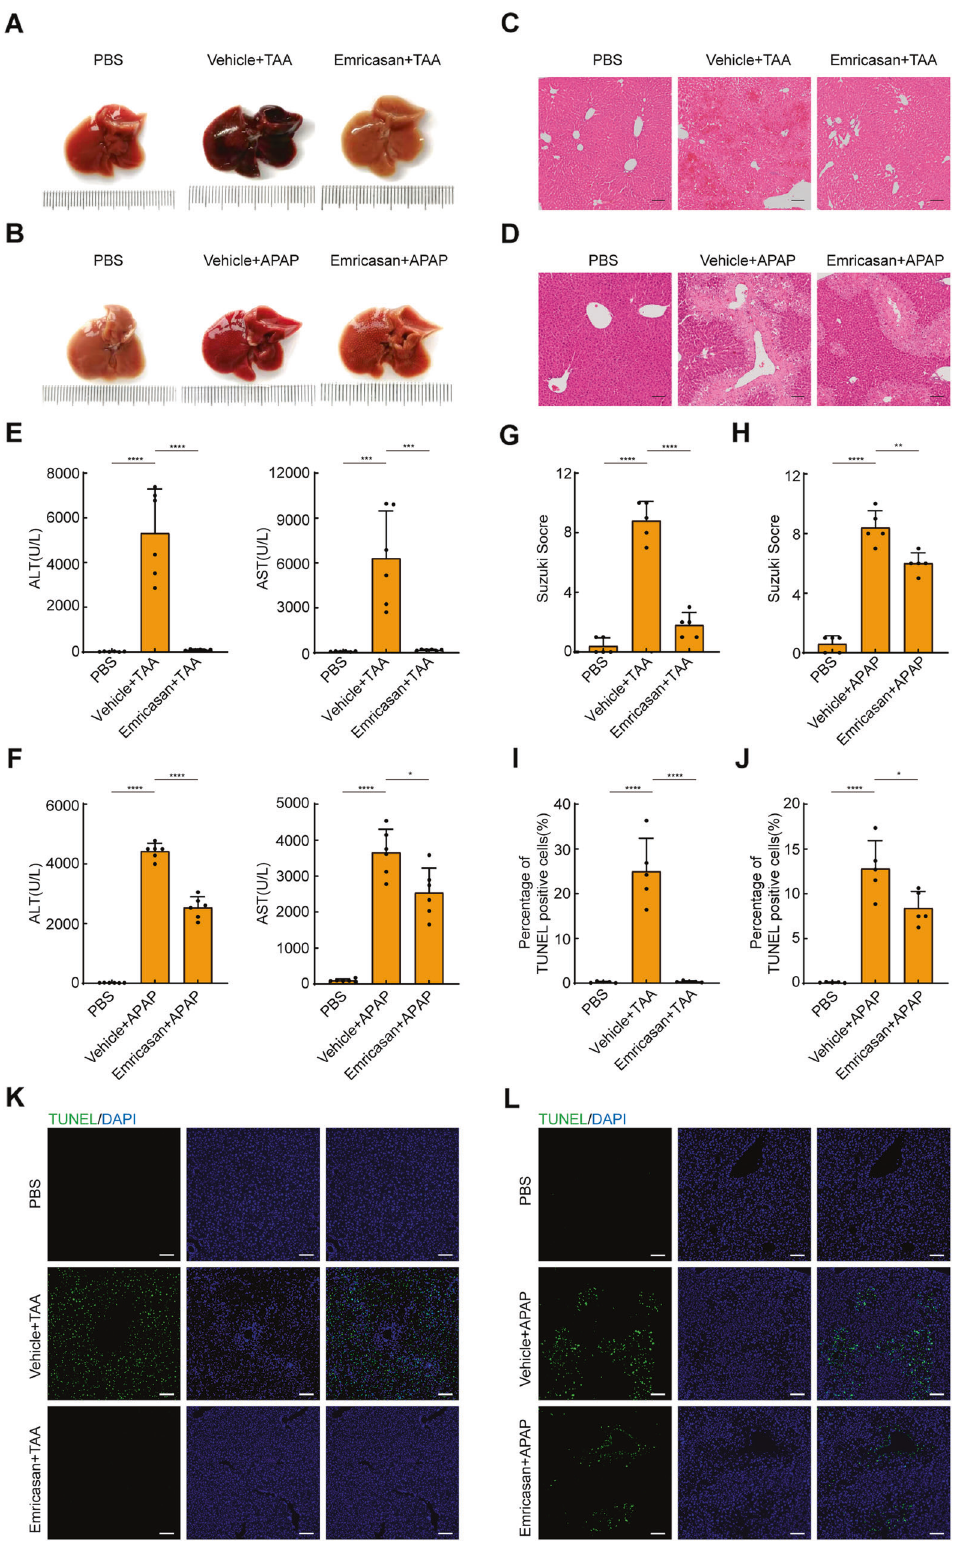
Fig. 5 Emricasan attenuates ALF induced by TAA or APAP. A , B Representative macroscopic appearance of livers at 24 h following TAA or APAP treatment in the presence or absence of emricasan. C , D Representative H&E-stained liver sections. Scale bars, 100 μ m. E , F Serum levels of ALT and AST(U/L) ( n = 6; mean ± s.d.). P values were determined by Student ’ s t test (* P < 0.05; *** P < 0.001; **** P < 0.0001). G , H Suzuki score of H&E-stained liver sections ( n = 5; mean ± s.d.). P values were determined by Student ’ s t test (** P < 0.01; **** P < 0.0001). I , J Percentage of TUNEL positive cells in liver sections ( n = 5; mean ± s.d.). P values were determined by Student ’ s t test (* P < 0.05; **** P < 0.0001). K , L Representative TUNEL-stained liver sections. Scale bars, 100 μ m. All experiments were repeated at least two times.